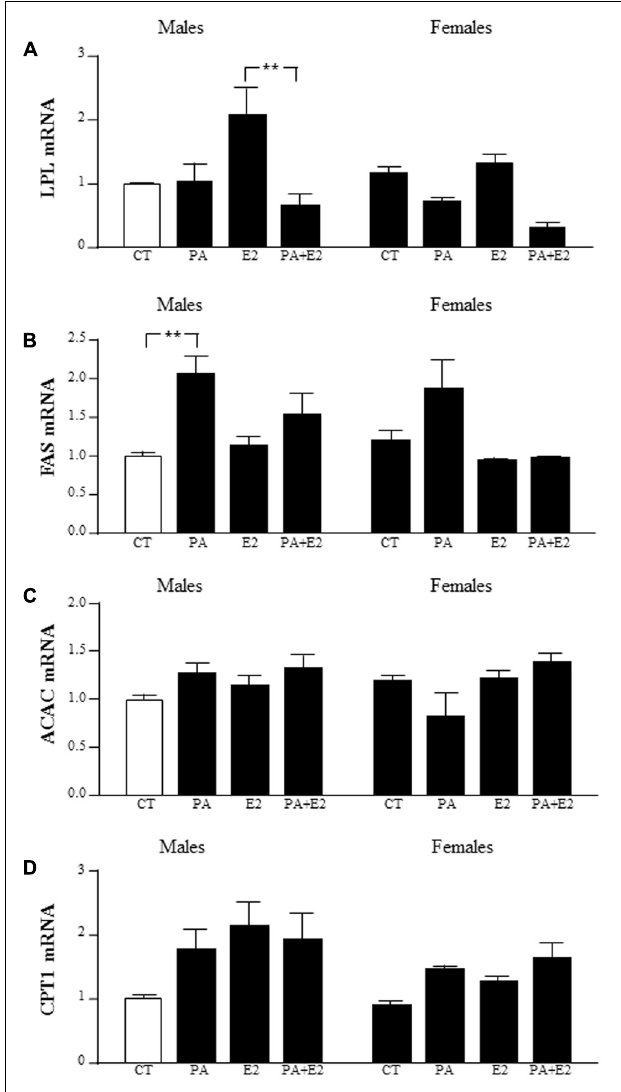
β E2 on lipoprotein lipase (LPL), fatty acid synthase (FAS), acetyl coA carboxylase (ACAC), and carnitine palmitoyltransferase (CPT1) mRNA levels. Astrocyte cultures were treated with PA (0.5 mM), E2 (10 − 10 M) or the combination of both. Relative mRNA levels of LPL (A) , FAS (B) , ACAC (C) , and CPT1 (D) in male and female astrocyte cultures. The average of three independent assays performed in duplicate is shown. Statistical significance: ∗∗ p <